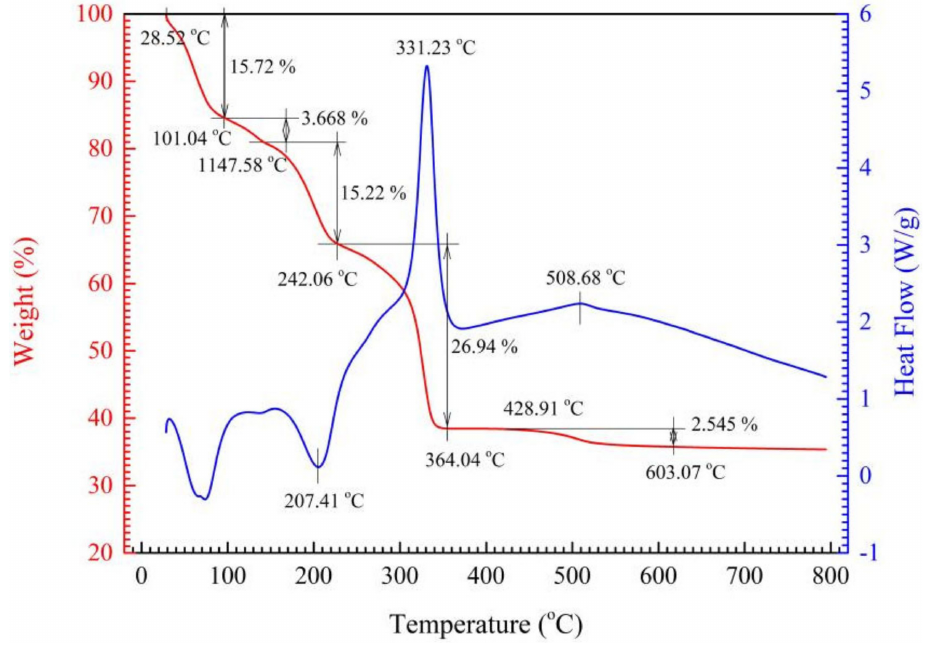
Figure 3. TG and DSC curves of S4 ceramic